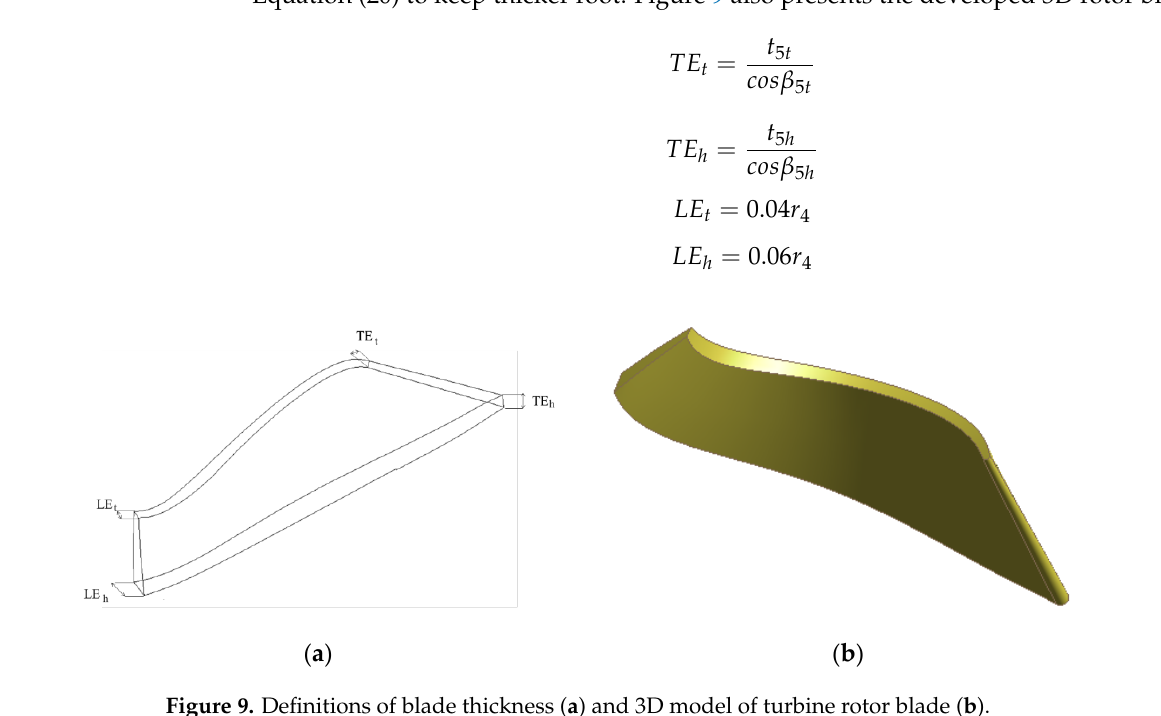
Figure 11. 3D view of a radial turbine stage and boundary conditions.